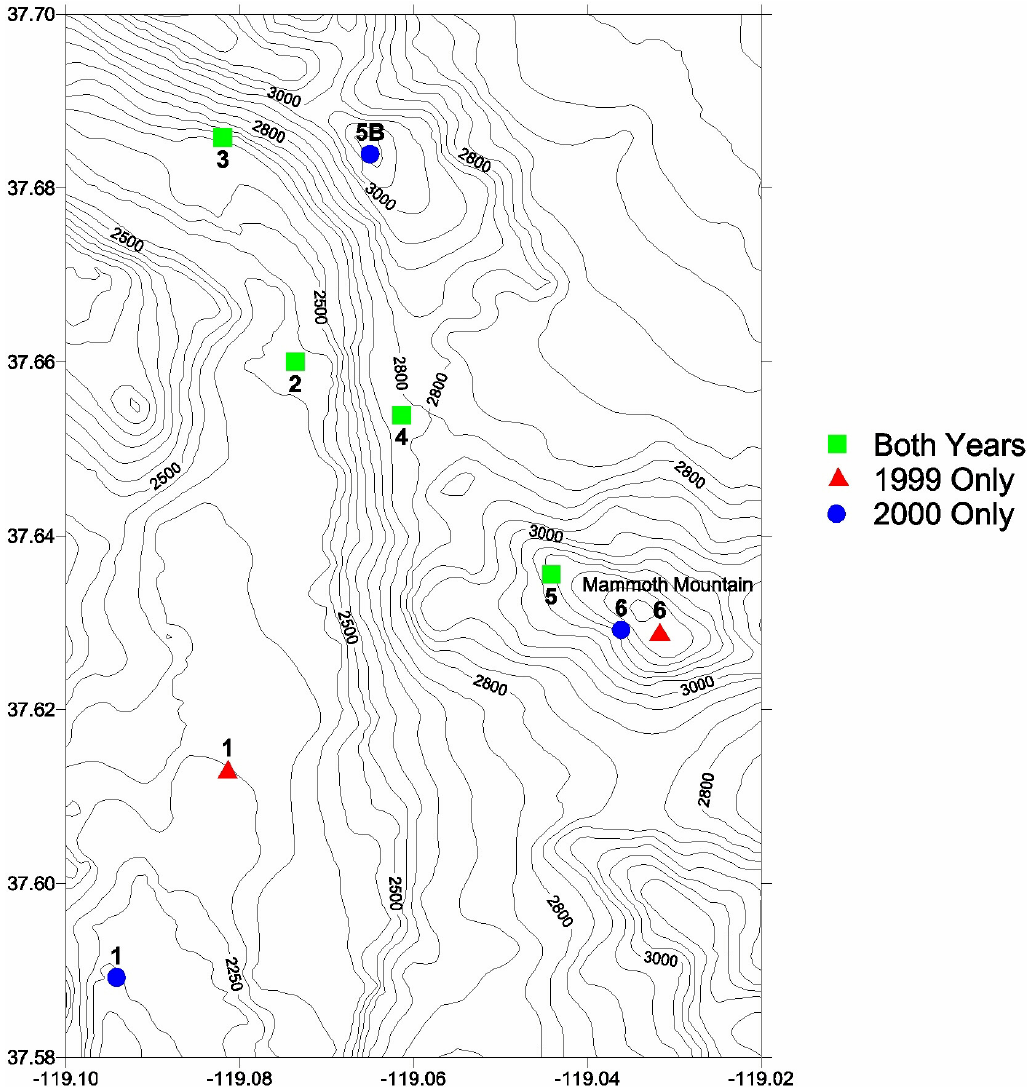
FIGURE 2 . Location of monitoring sites on Mammoth